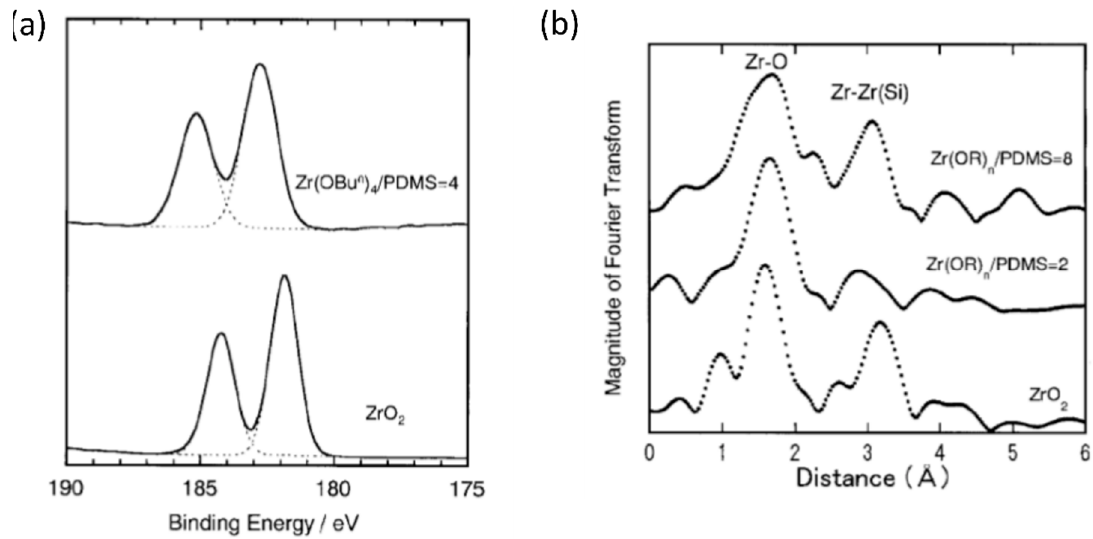
Figure 13. ( a ) Zr 3d XPS spectra of a PDMS–ZrO 2 hybrid (ZBO/PDMS molar ratio of 4) and ZrO 2 ; ( b ) Fourier transforms of extended X-ray absorption fine structure spectroscopy (EXAFS_ spectra for PDMS-ZrO 2 hybrids (ZBO/PDMS ratio of 8 and 2) and ZrO 2 . Reproduced with permission from Katayama et al. Journal of the American Ceramic Society ; published by Wiley–Blackwell, 2002.